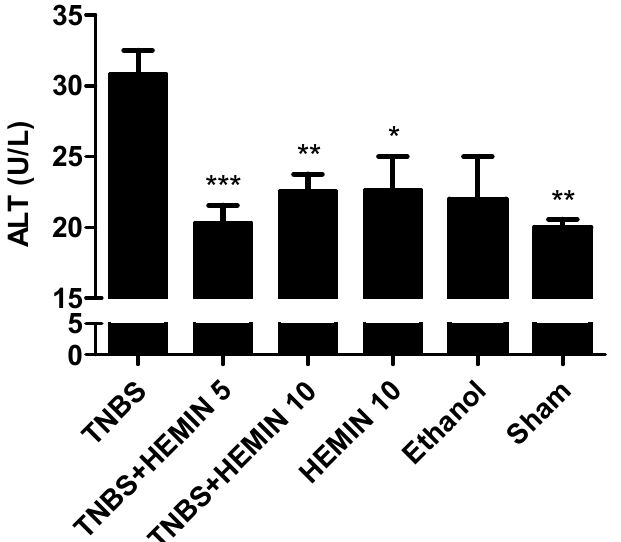
Figure 7. Effect of hemin treatment on ALT concentration in the IBD. Legend: One-way ANOVA for multiple comparisons and Tukey’s post hoc test. * p < 0.05; ** p < 0.01; *** p < 0.001; compared with TNBS group.